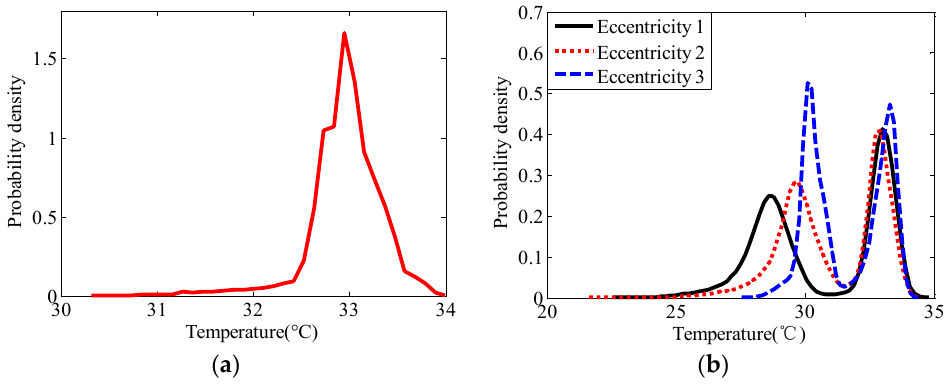
Figure 13. TPDs in experiment under different insulation eccentricities: ( a ) normal, ( b ) eccentricity.